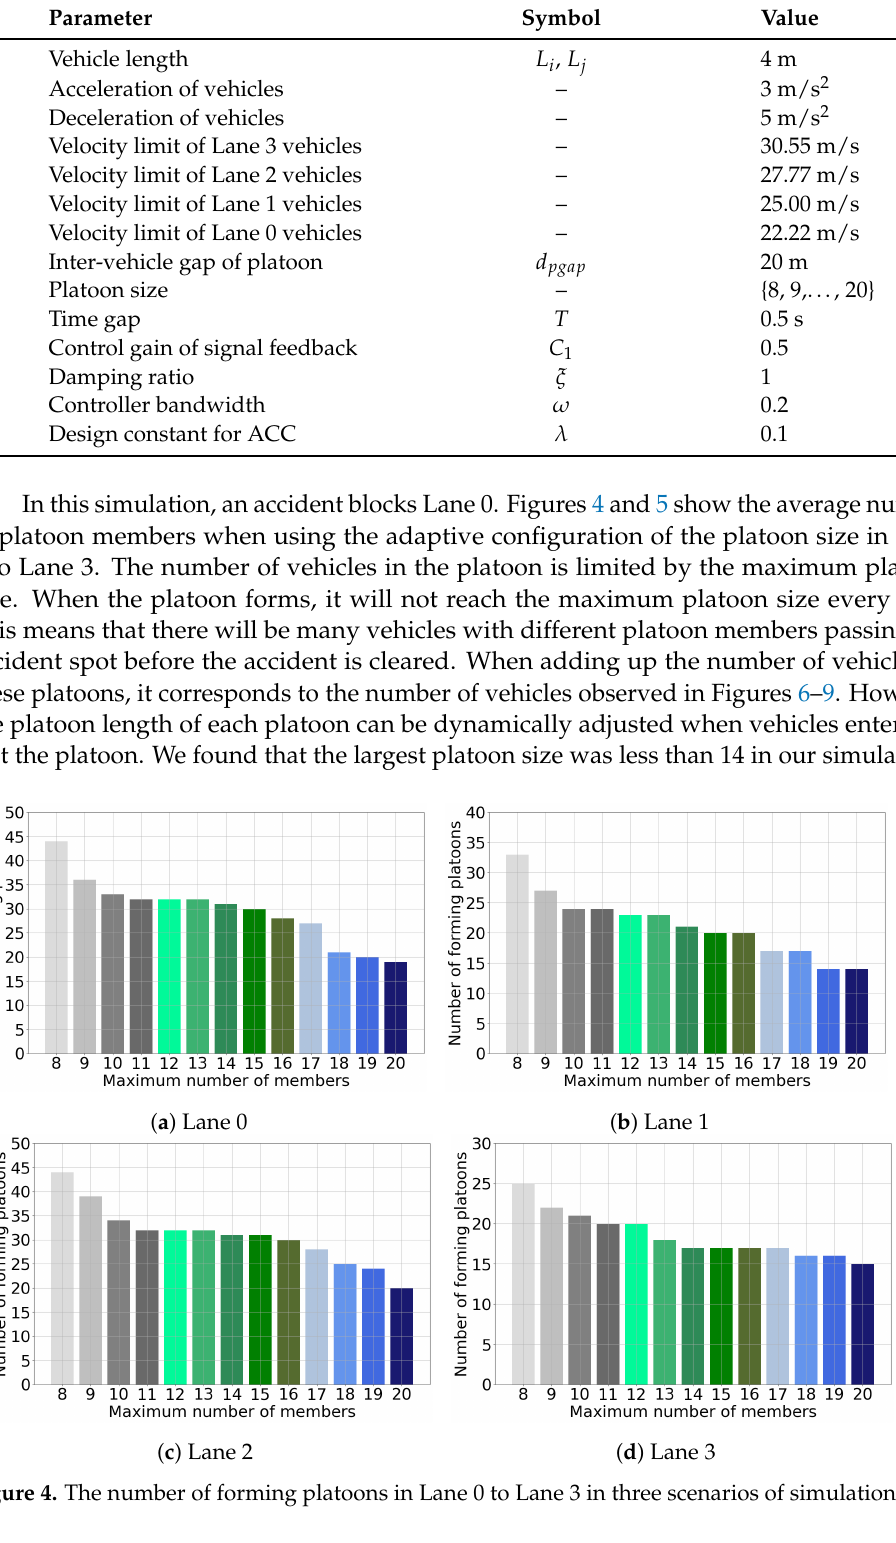
Table 3. Parameters of the system model.